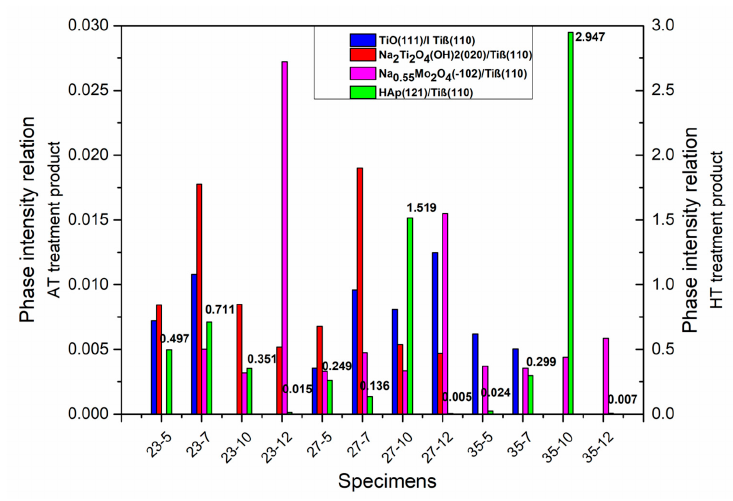
Figure 14. The intensity pairs of the products phase relation values collated in changeable substrate composition and AT treatment solution concentration.